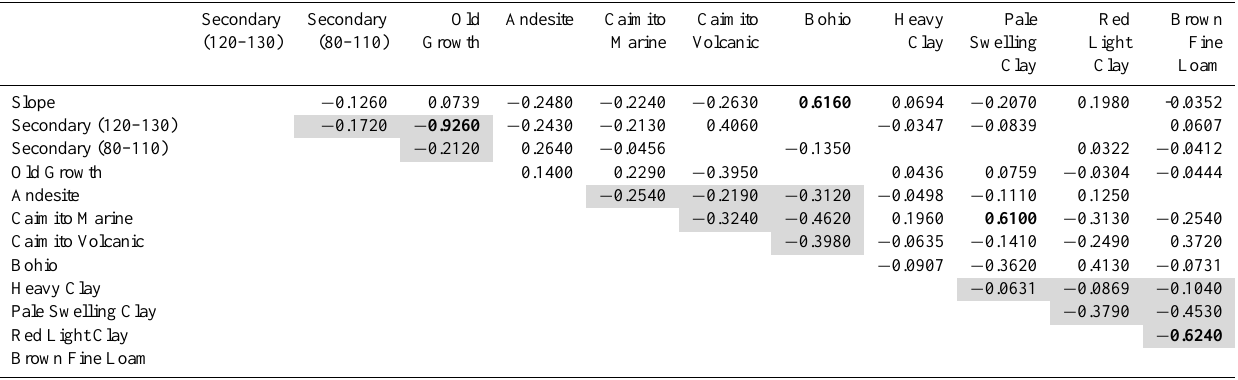
Table 5. Correlation coefficients (Pearson’s R) for model variables examined for controlling carbon density on BCI, Panama. Grey areas indicate mutually exclusive categorical variables (forest age, bedrock, soil texture). Only correlations significant at P < 0 . 0007 are shown (after Bonferroni correction for 66 comparisons). Correlations of R > 0 . 5 are highlighted in